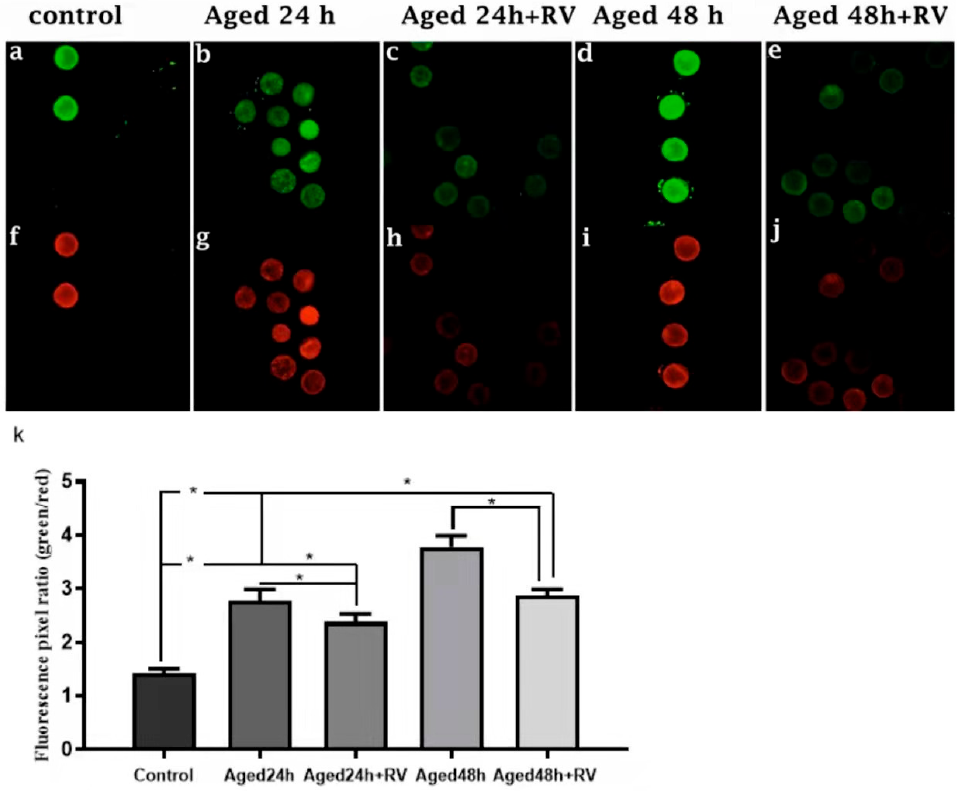
Figure 5. RV rescues the mitochondrial membrane potential in aged porcine oocytes. Representative Fluorescent images of JC-1-stained oocytes. Cultured in the absence or presence of 2 µ mol/L RV. ( a , f ) Control; ( b , g ) aged 24 h; ( c , h ) aged 24 h + RV; ( d , i ) aged 48 h; ( e , j ) aged 48 h + RV. ( k ) Quantitative analysis of JC-1 red/green fluorescence intensity ratio in porcine oocytes. Membrane potential was calculated as the ratio of red fluorescence, which corresponds to activated mitochondria (J-aggregates), and to green fluorescence, which corresponds to less-activated mitochondria (J-monomers). Fluorescence emitted from each oocyte was analyzed using the ImageJ software. Significant difference (* p < 0.05).